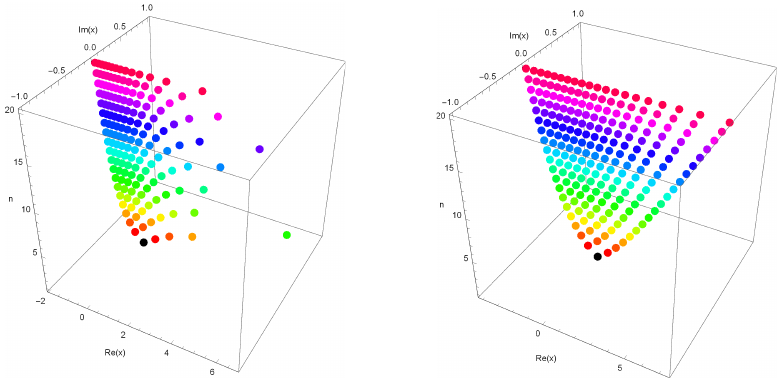
Figure 3. Stacks of zeros of H n , q ( x ) ,1 ≤ n ≤ 20.